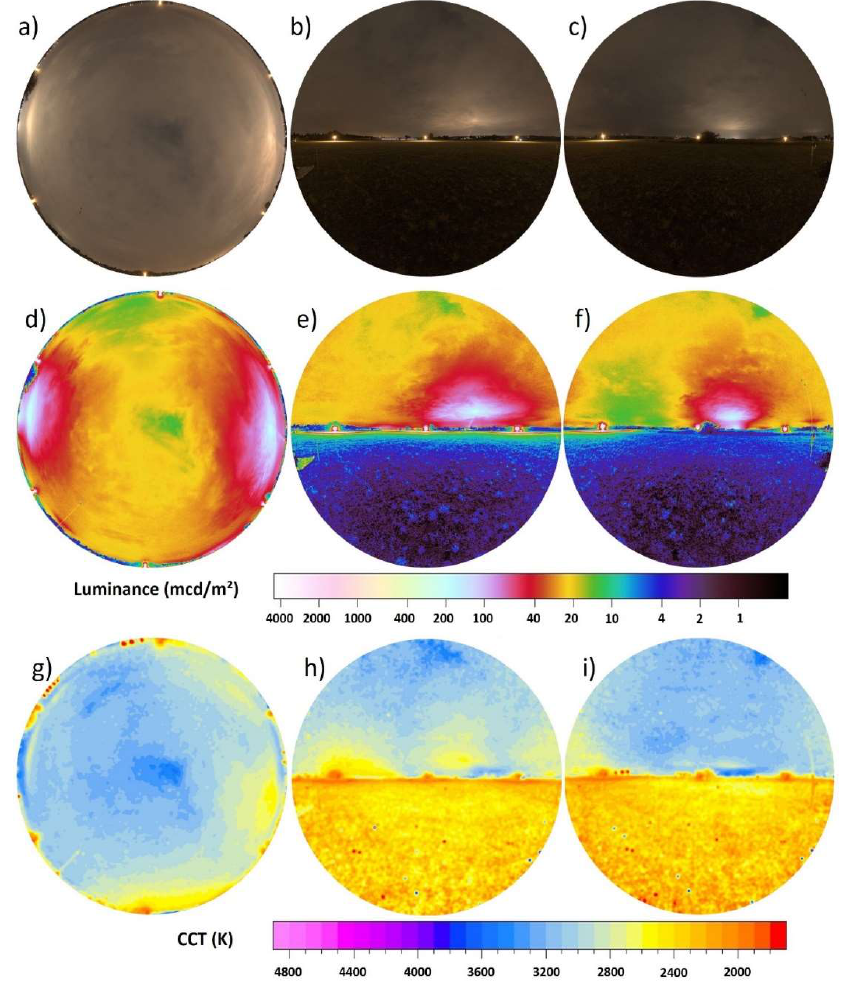
Figure 4. Full data set of Figure 3 with upper row ( a – c ) showing RGB images, the center row ( d – f ) luminance maps and lower row ( g – i ) CCT maps. The left column ( a , d , g ) shows the all-sky data the middle ( b , e , h ) and right ( c , f , i ) columns the vertical plane data.